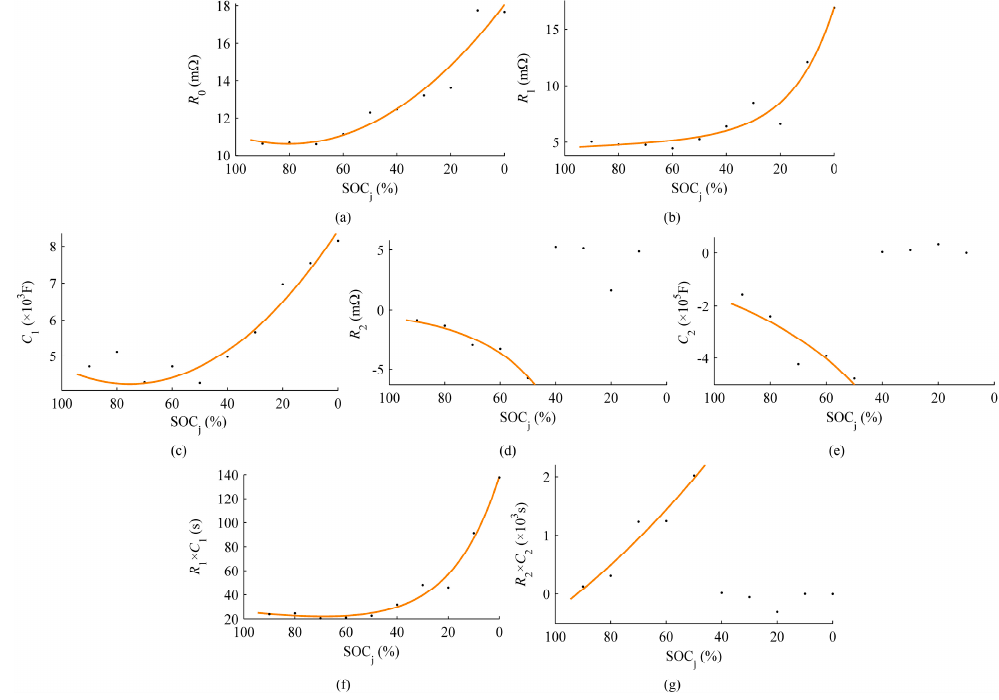
Figure 10. Identified ( a ) R 0 ; ( b ) R 1 ; ( c ) C 1 ; ( d ) R 2 ; ( e ) C 2 ; ( f ) R 1 × C 1 and ( g ) R 2 × C 2 under { i 1 = − 3.9 A, i